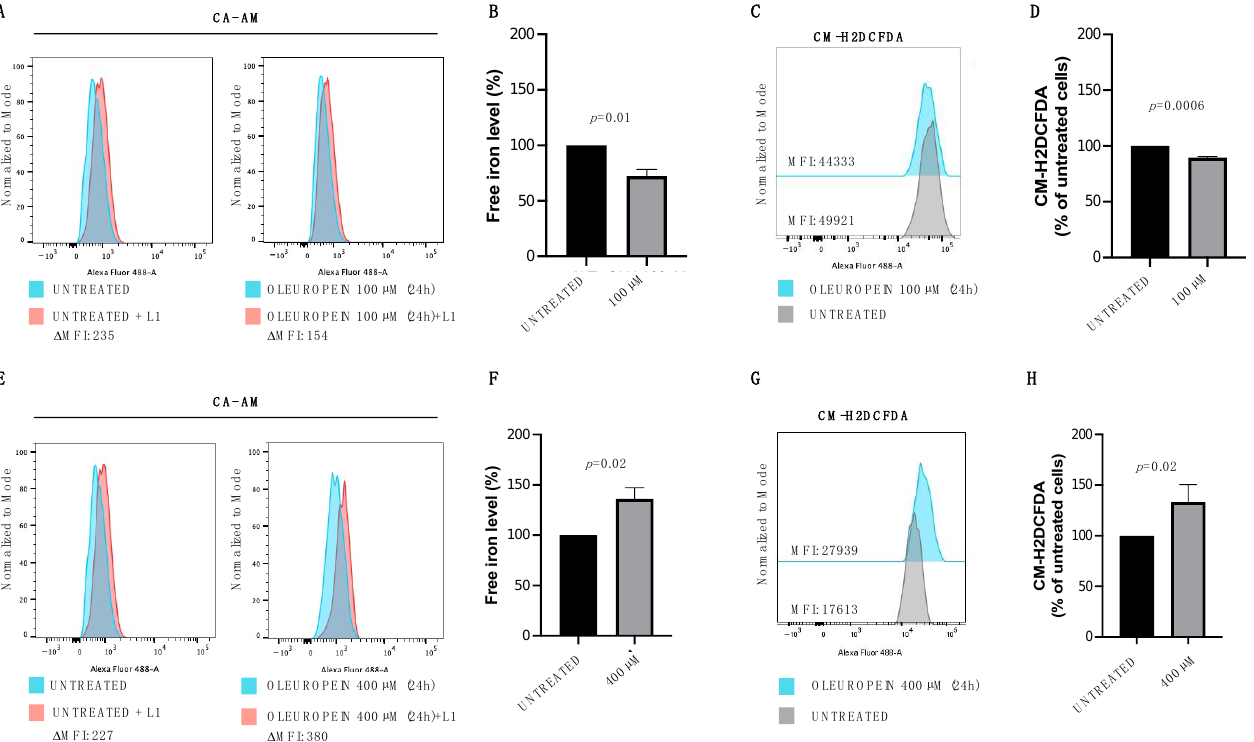
Figure 2. Pro- and antioxidant activity of oleuropein is dose-dependent. ( A ) Flow cytometry histogram showing LIP levels assessed using Calcein-AM assay in HEY cells untreated and treated with OLE (100 µ M) for 24 h. ( B ) A bar diagram showing LIP levels presented as the % of control (untreated HEY cells). ( C ) Flow cytometry histogram showing the analysis of cytosolic ROS measured upon staining with CM-H2DCFDA in HEY cells untreated and treated with OLE (100 µ M) for 24 h. ( D ) A bar diagram showing ROS levels presented as the % of control (untreated HEY cells). ( E ) Flow cytometry histogram showing LIP levels assessed using Calcein-AM assay in HEY cells untreated and treated with OLE (400 µ M) for 24 h. ( F ) A bar diagram showing LIP levels presented as the % of control (untreated HEY cells). ( G ) Flow cytometry histogram showing analysis of cytosolic ROS measured upon staining with CM-H2DCFDA in HEY cells untreated and treated with OLE (400 µ M) for 24 h. ( H ) A bar diagram showing ROS levels presented as the % of control (untreated HEY cells). Values (mean ± SEM; n = 3) are shown. Statistically significant difference was determined by Student’s t